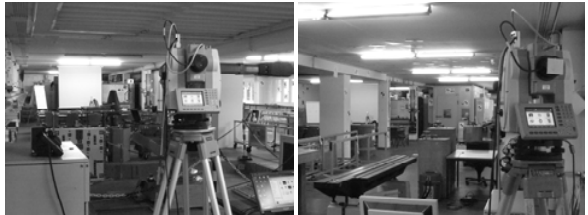
Figure 3. Experimental setup: Instrument positions with the target in the background (pictures taken by Elsa